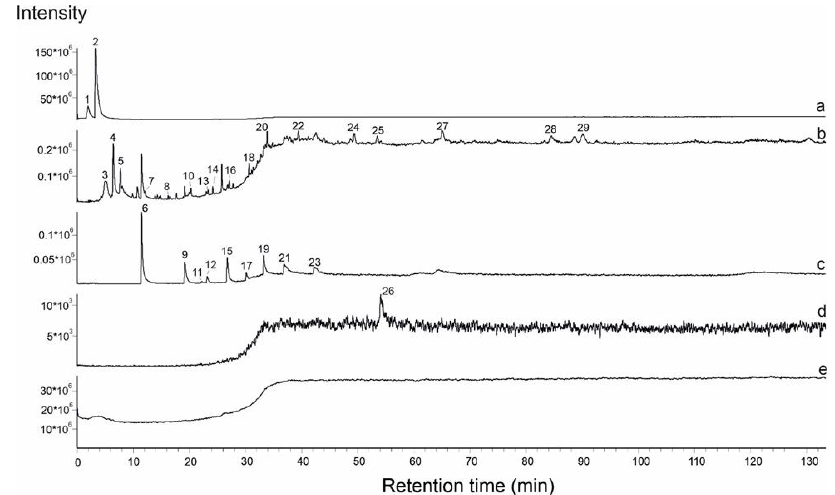
Figure 9. Results of a GC – MS analysis of volatiles extracted via mechanical shock crushing from arsenopyrite D10 of the Dobroe deposit. Total ion chromatogram (TIC) (a) and reconstructed ion chromatograms (RIC) for m / z (43 + 57 + 71 + 85) (b), m / z 60 (c), m / z 149 (d), and blank (TIC) (e).